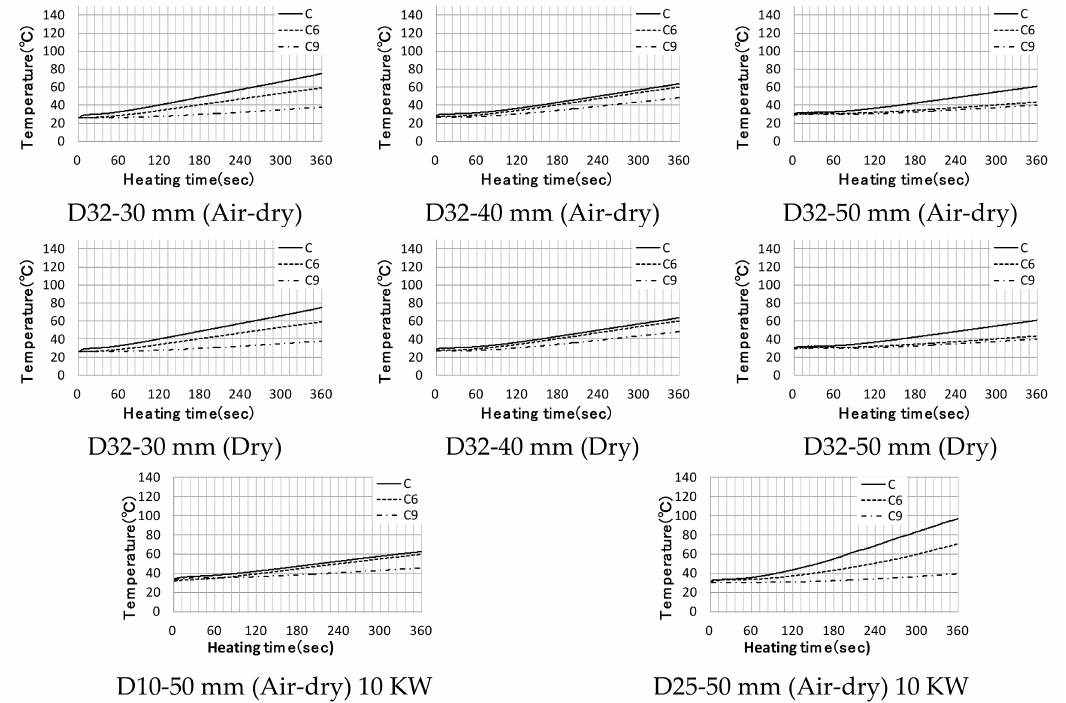
Figure 6. Increase in temperature with time in reinforced concrete caused by induction